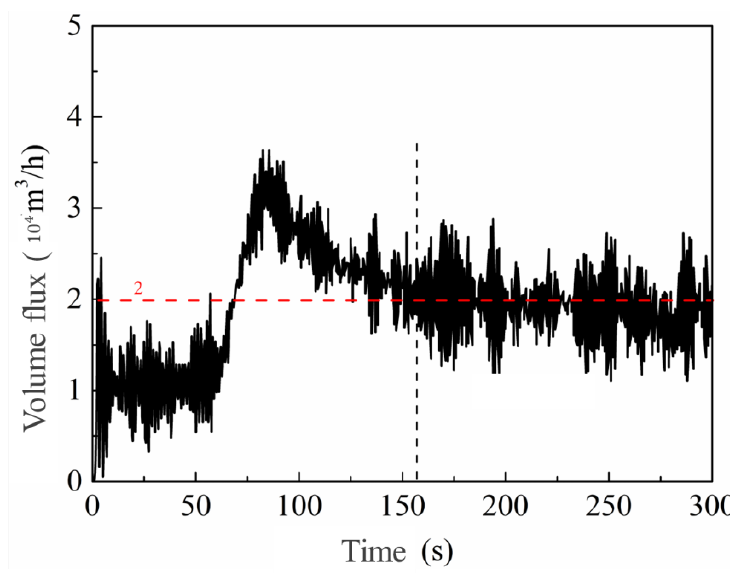
Figure 13. Volume flow on tunnel cross section.